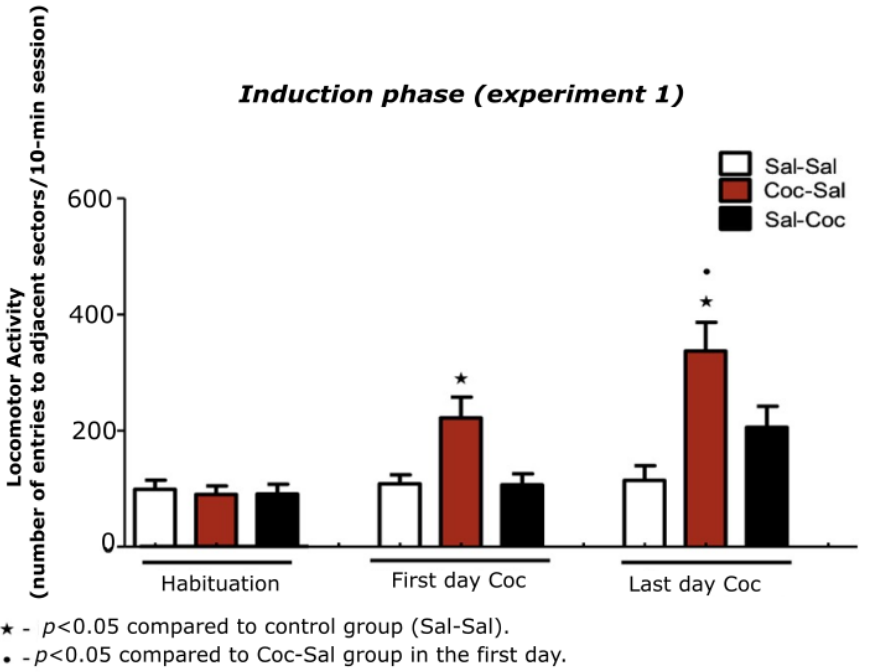
Figure 2. Total locomotion of the animals in the induction phase of cocaine-induced behavioral sen- sitization.